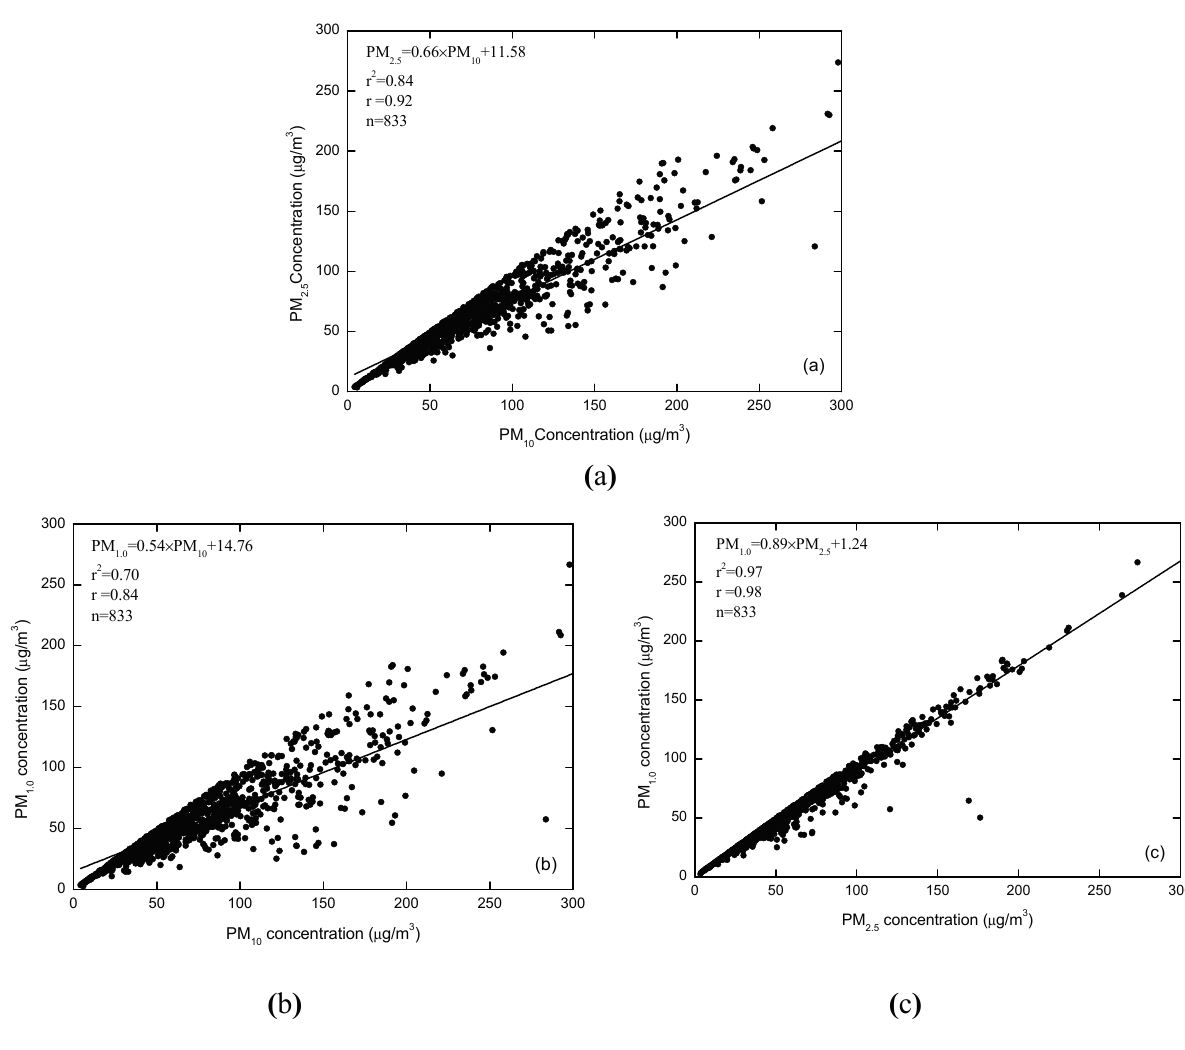
Figure 2. Correlation between average mass concentrations of PM 10 , PM 2.5 and PM 1.0 : ( a ) PM 10 vs. PM 2.5 , ( b ) PM 10 vs. PM 1.0 , ( c ) PM 2.5 vs. PM 1.0